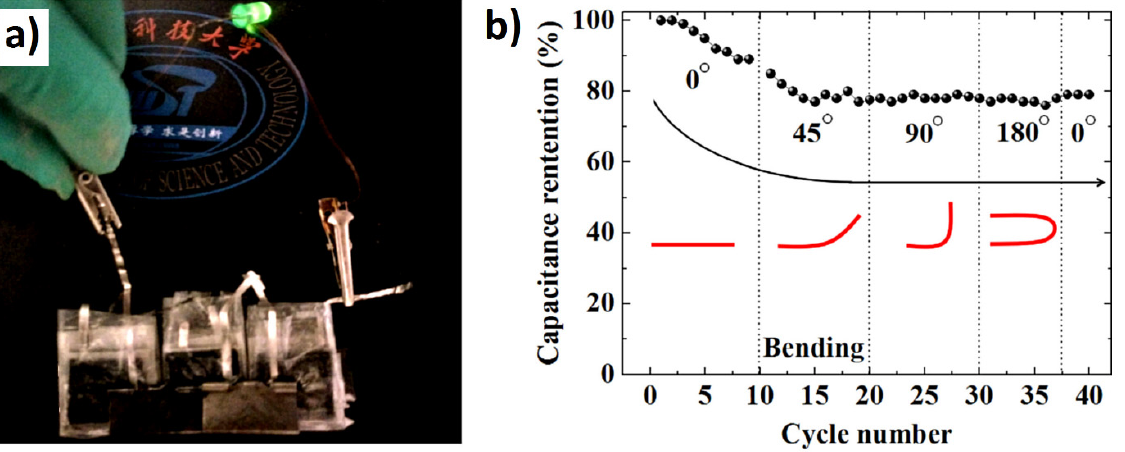
Figure 10. ( a ) A demonstration of six FSCs connected in series lighting a green LED bulb; ( b ) Capacitance retention of the FSC based on MnO 2 /MGF/NF with a loading time of 12 h, with a dynamic bending process. Reprinted from ref. [37] with permission from Elsevier B.V.